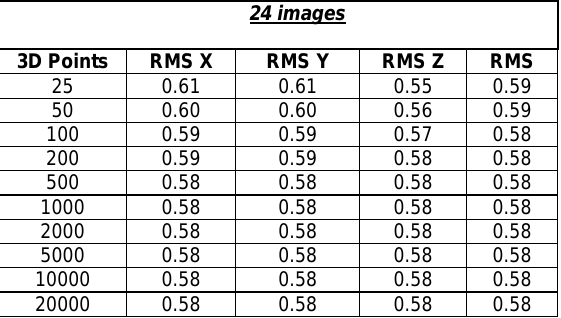
Table 3. RMS for the closed sequence around a flat object. Precision does not depend on the number of 3D points.